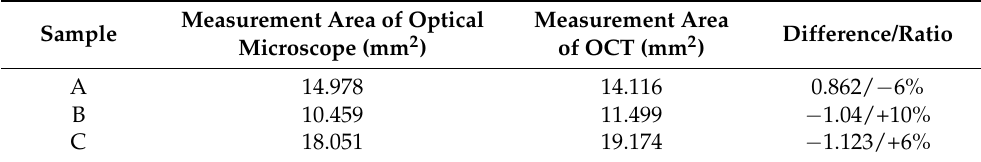
Figure 6. The bar graph shows the difference of residual adhesive between optical microscope and OCT image areas. The left bar of each sample represents the area of optical microscope measurement. The right bar of each sample represents the area of the OCT image. The grid of graph shows the difference in the area of each sample. Table 1. The actual area of the residual adhesive and the area of the residual adhesive obtained by the OCT image. Difference and ratio between the two areas.